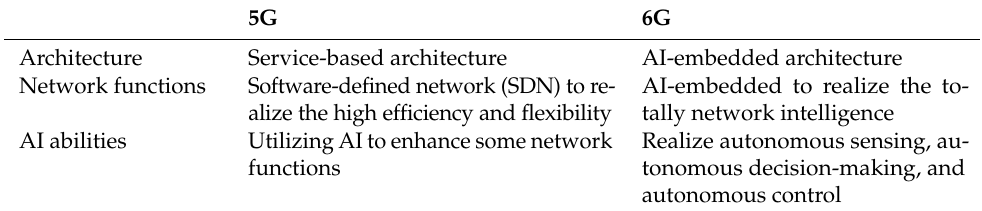
Table 2. The differences of AI abilities in 5G and